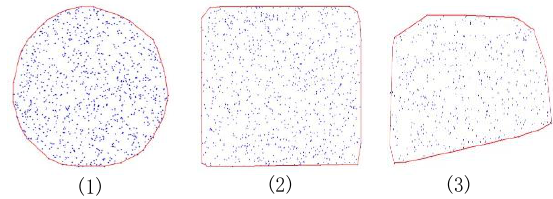
Figure 4. The minimum convex hull of 1000 random points